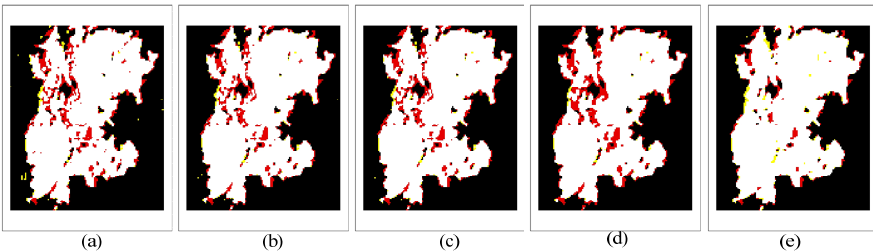
Remote Sens. 2016 , 8 , 264